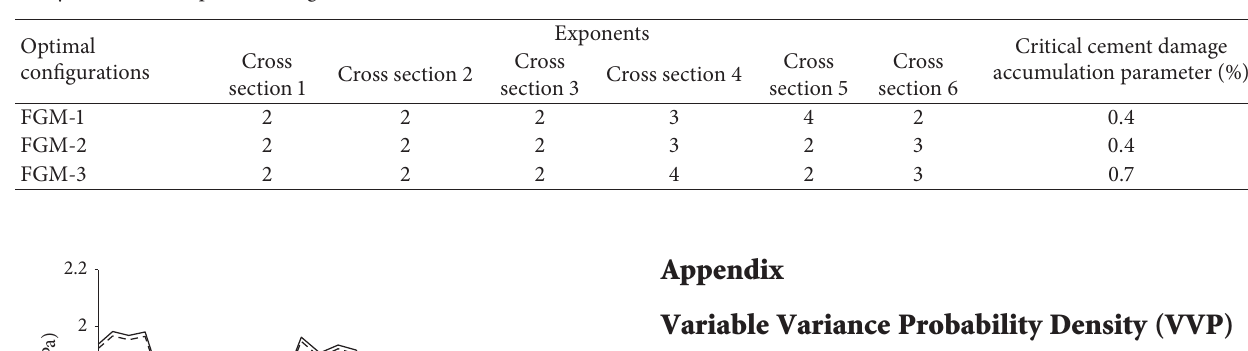
Table 4: Values of the exponents over the cross sections in Figure 2 along with the critical cement damage accumulation parameter at 2.0 × 10 6 cycles for three optimal configurations.